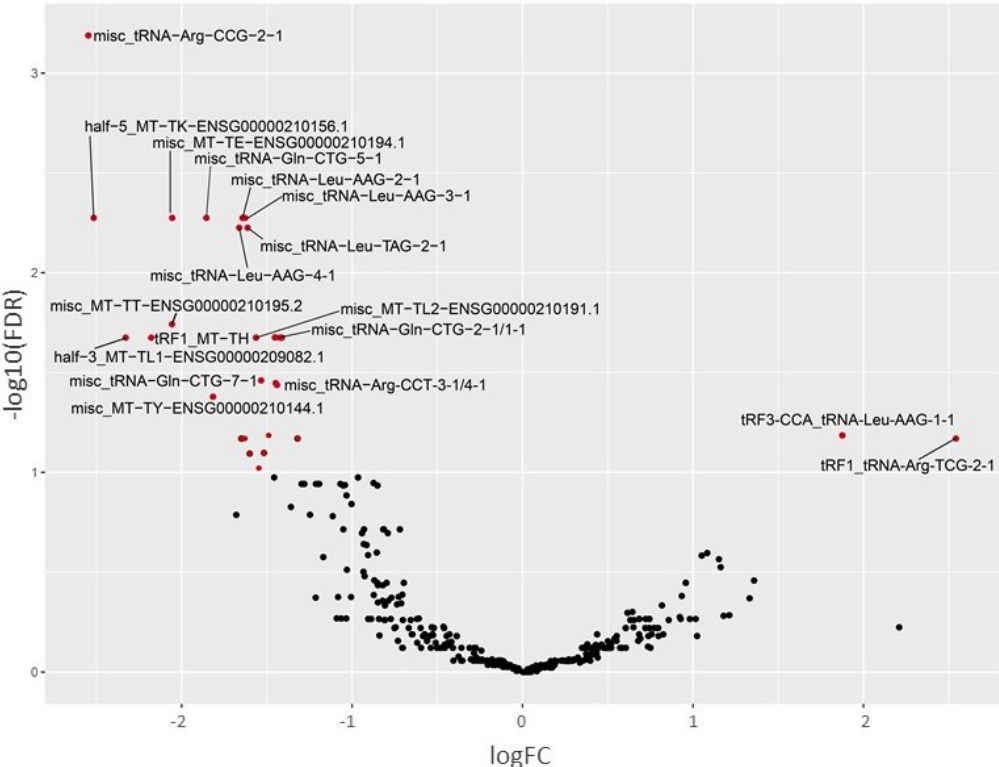
Figure 3. Volcano plot showing the differentially expressed tRNA fragments in TG compared to normal allograft. Significant changes with LFC2 > 1 with FDR < 0.1 are labeled